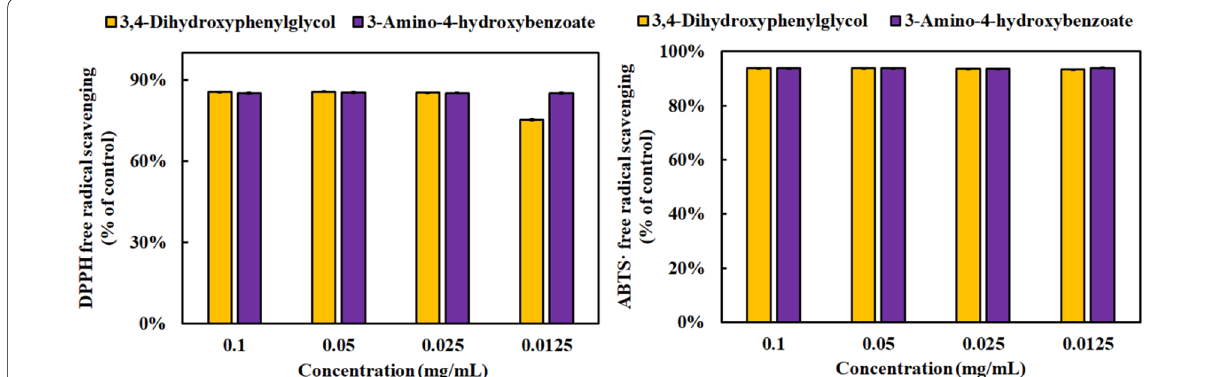
Fig. 8 Antioxidant capacity of 3,4‑dihydroxyphenylglycol and 3‑amino‑4‑hydroxybenzoate using DPPH and ABTS scavenging methods. Results are mean S.D. (n 3) ± =